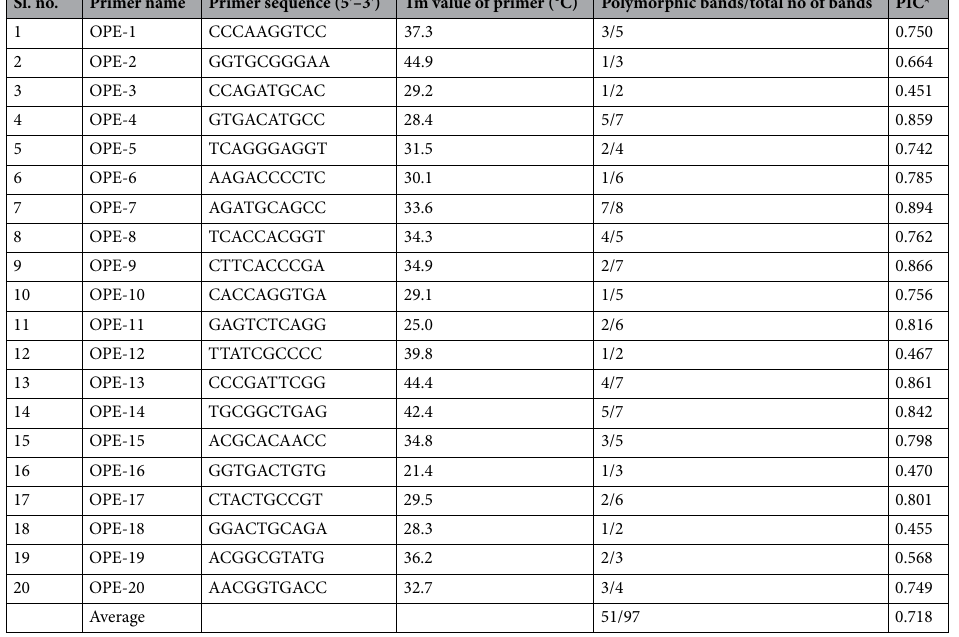
Table 1. Summary of genetic diversity obtained by RAPD primers. PIC polymorphic information content.